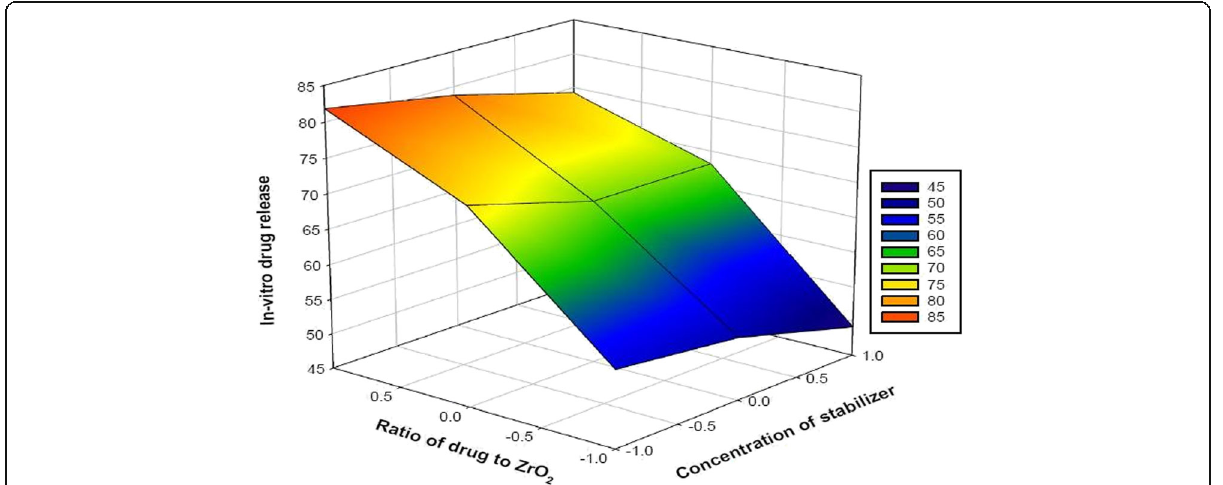
Fig. 6 3D mesh plot of showing the effect of concentration of stabilizer and the ratio of drug to ZrO 2 on in vitro drug